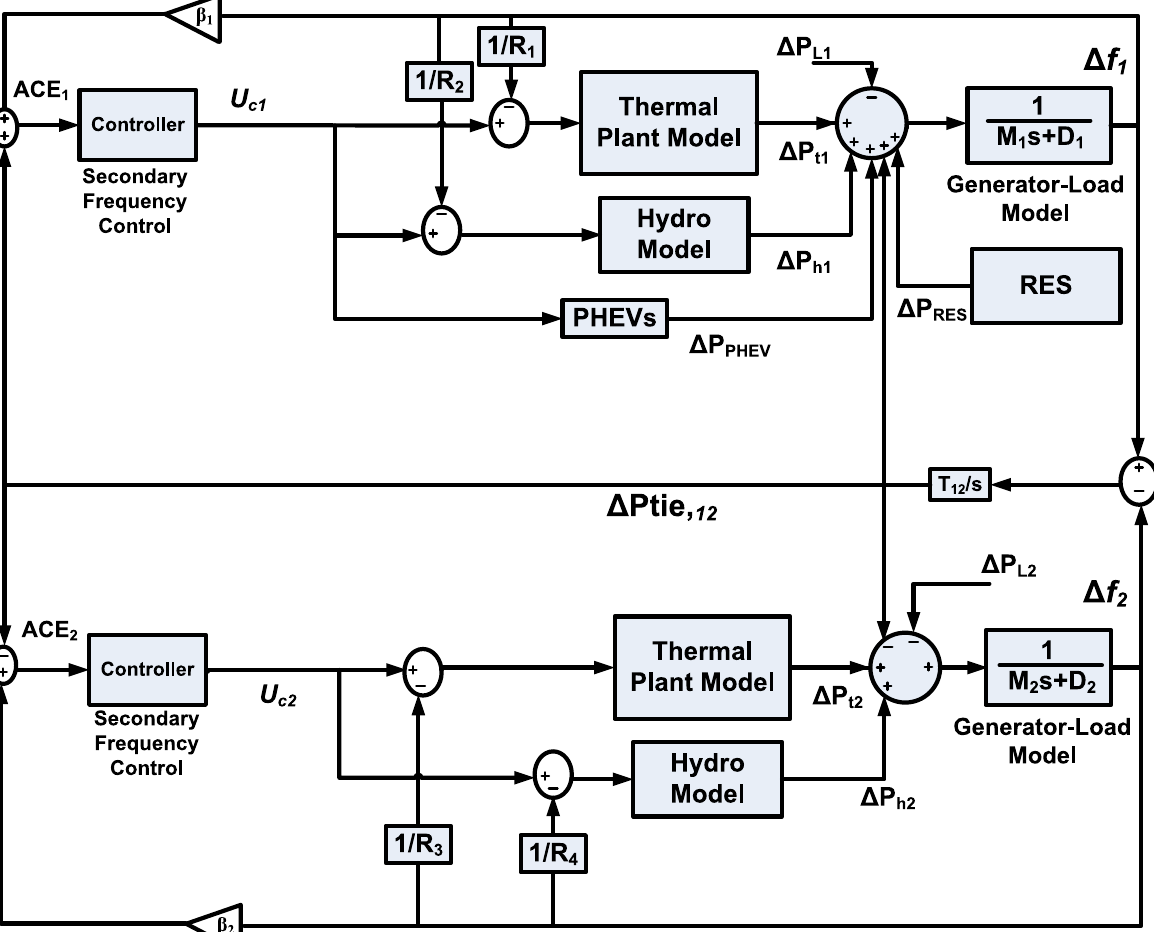
Fig. 2 Two-area power system model with RES and